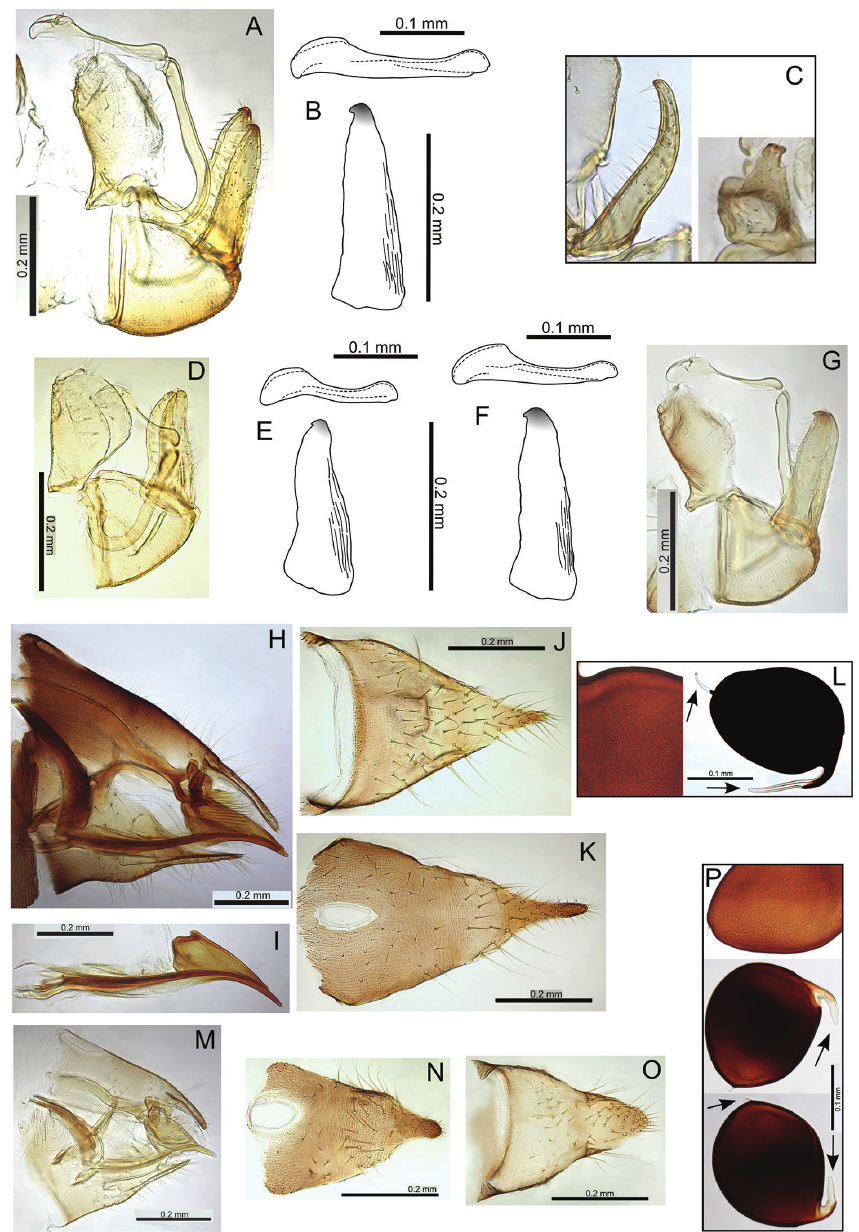
Figure 35. Pariaconus ohiacola . A, B, C form ohiacola : A male terminalia B aedeagus and paramere C paramere posterior view (left) dorsal view (right) D, E form waianaiensis : D male terminalia E aedeagus and paramere F, G form obtusipterus : F aedeagus and paramere G male terminalia H, I, J, K, L form ohiacola : H female terminalia I ovipositor J female subgenital plate (ventral view) K female proctiger (dor- sal view) L eggs (pedicel and tail indicated, microsculpturing detailed) M, N, O, P form waianaiensis : M female terminalia N female proctiger (dorsal view) O female subgenital plate (ventral view) P eggs (pedicel and tail indicated, microsculpturing